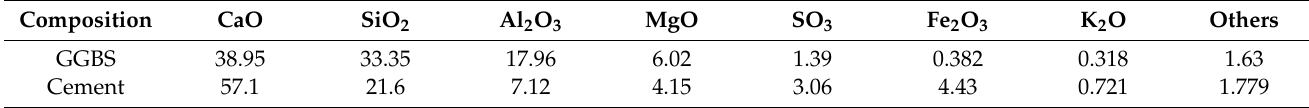
Table 1. The chemical composition of slag and cement (mass